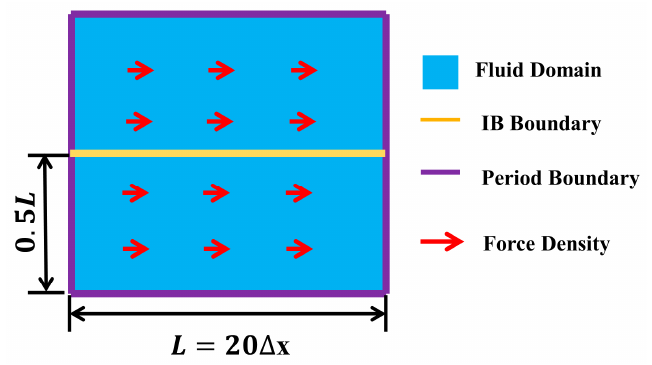
Figure 3. The computational domain of the symmetrical Poiseuille flow with one IB.